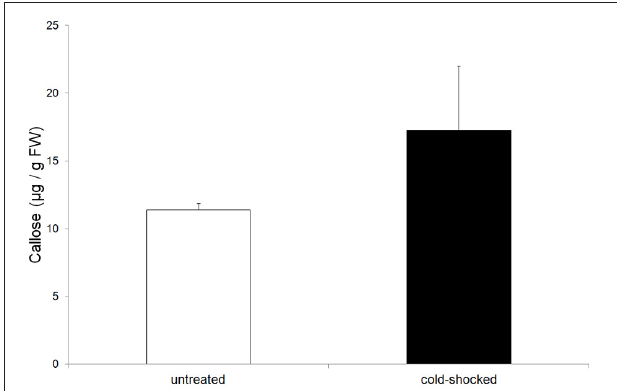
FIGURE 6 | Concentration of callose in untreated and cold-shocked leaves ( n = 4 ± SD). Callose increased significantly in cold-shocked